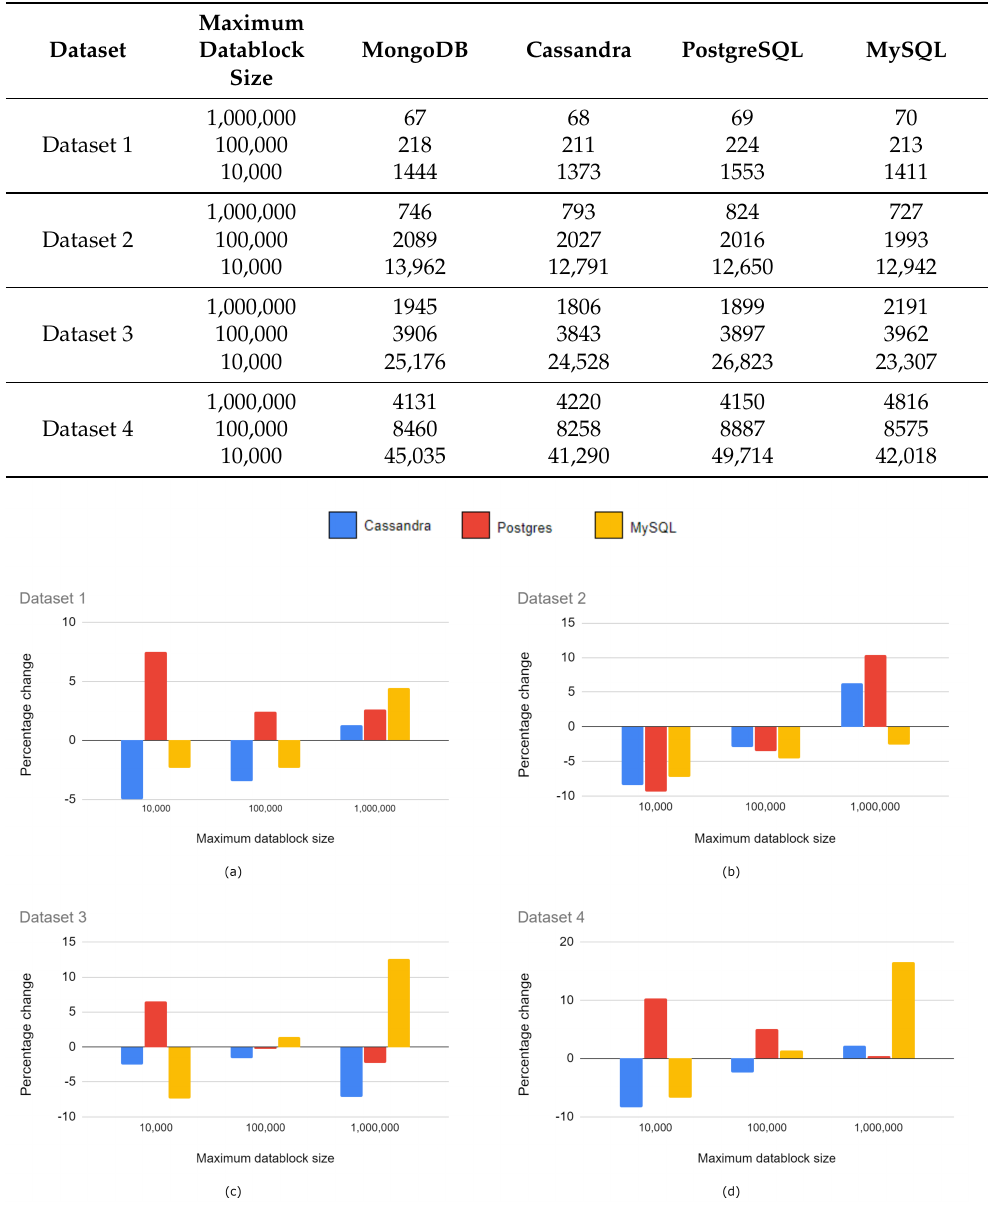
Table 2. Dataset upload times (in seconds) for the implementations based on MongoDB, Cassandra, PostgreSQL and MySQL.